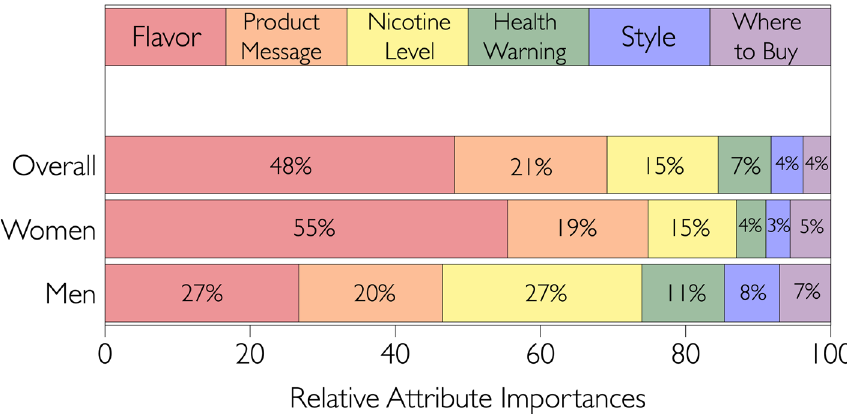
Figure 1. Relative importance of various attribute categories, based on discrete choices, for all participants (n = 587), and for women and men